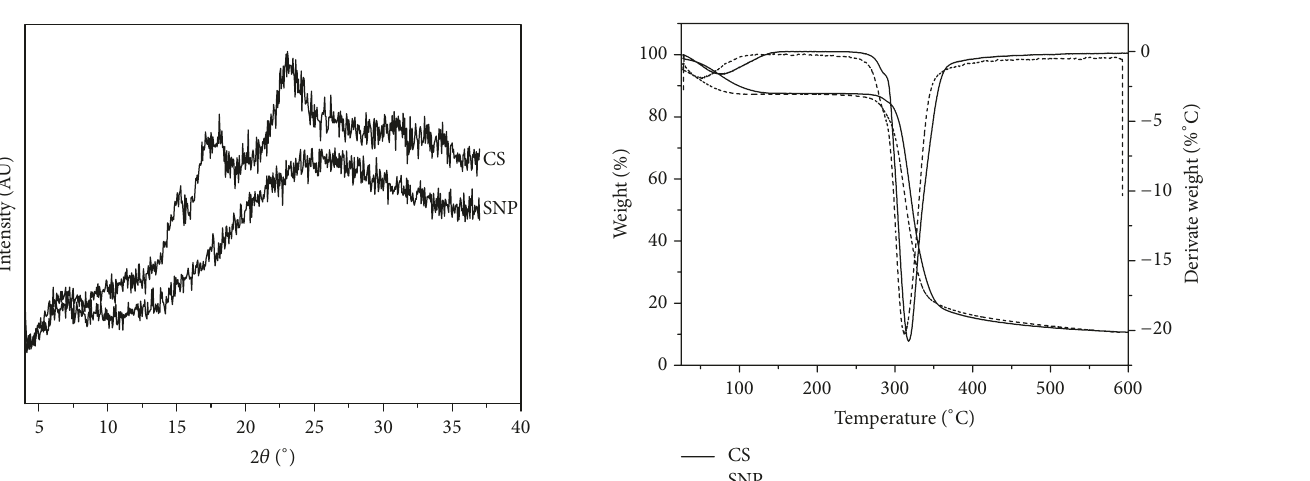
Figure 5: Thermogravimetric analysis (TG) and derivative ther- mogravimetric (DTG) curves of cassava starch (CS) and starch nanoparticles (SNP).